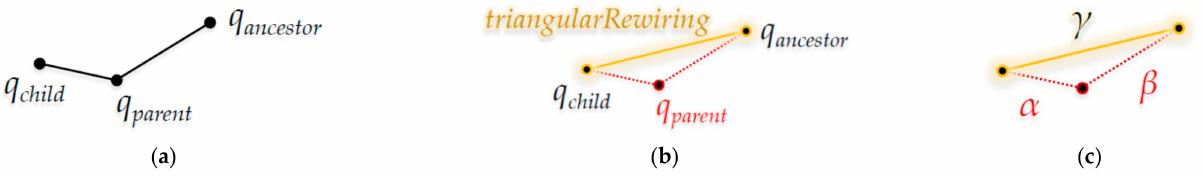
Figure 5. Abstract process of the ‘Triangular-Rewiring’ method: ( a ) Example tree; ( b ) After rewiring between q child and q ancestor ; ( c ) At this time, α is the distance between q child and q parent , β is the distance between q parent and q ancestor , and γ is the distance between q child and q ancestor